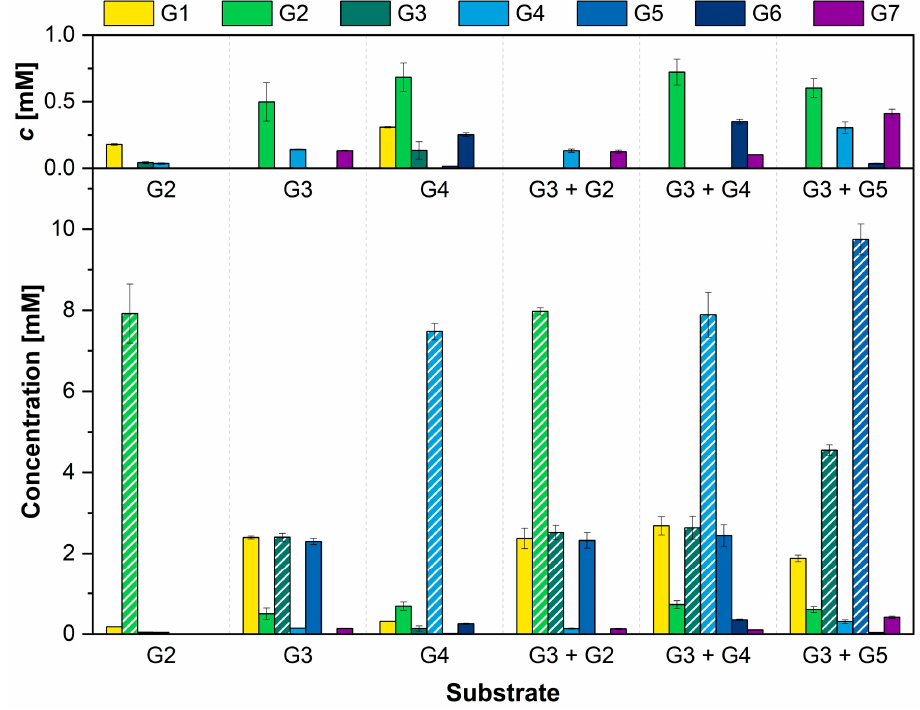
Figure 4. HPAEC-PAD analysis of AcbQ reaction products. Reaction mixtures contained maltose (G2), maltotriose (G3), maltotetraose (G4) or combinations of two α -1,4-glucans: G3 + G2, G3 + G4, G3 + G5. Measurements of the product spectrum (glucans with chain lengths G1–G7) of each assay combination are shown. Glucans that were added as substrates to the assay are marked with stripes. The inset shows a magni fi cation of glucans only with small concentrations below 1 mM ( n = 3).